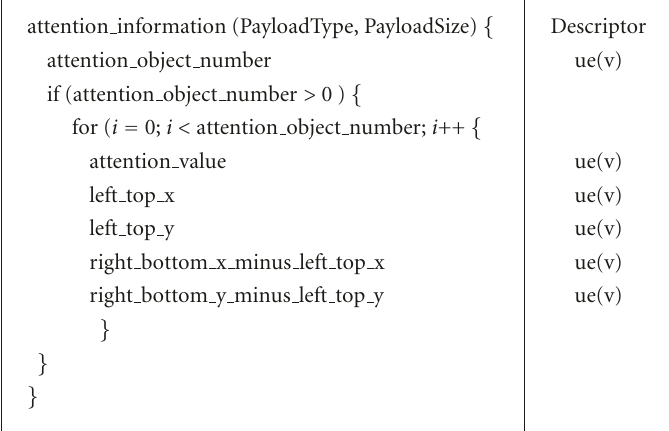
Figure 4: Proposed SEI structure for attention